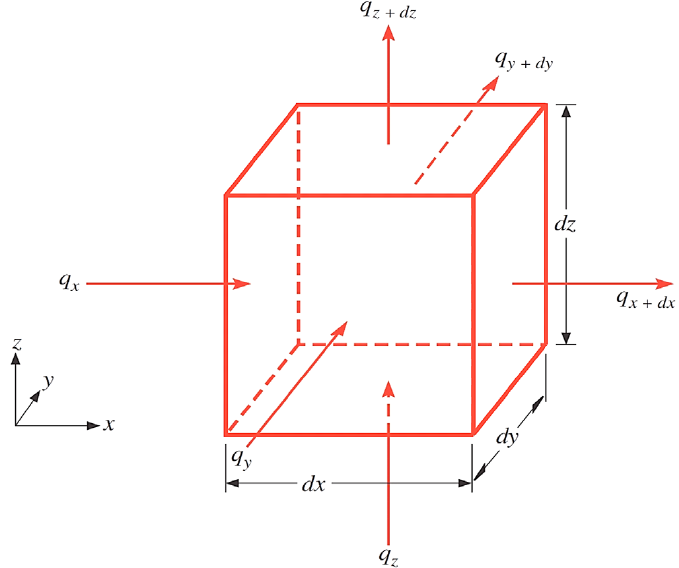
Figure 2. Heat conduction in differential control volume.